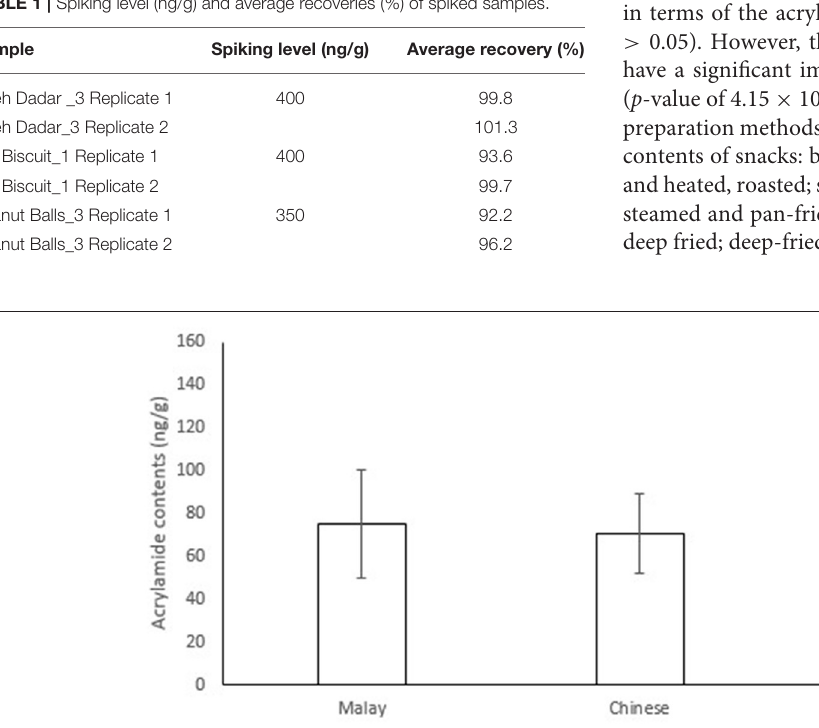
FIGURE 1 | Average acrylamide contents (ng/g) ± standard errors in snacks consumed by three ethnic groups.